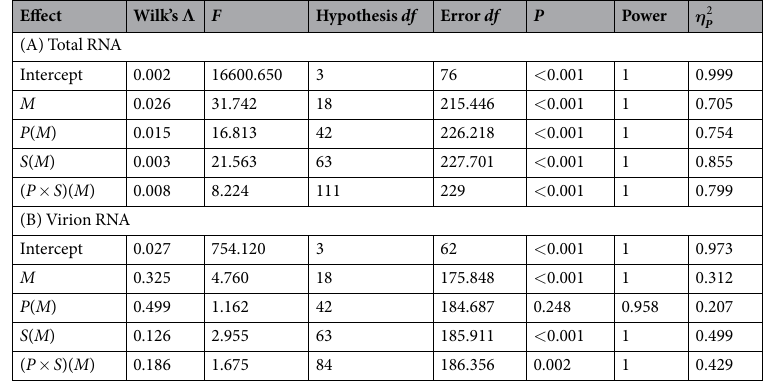
Table 1. Results of the MANOVA analysis for the RNA frequencies estimated from total and from virion RNA extractions in experiments with variable input ratios done in N. benthamiana . The model fitted is shown in equation (1). M : inoculated mixture of RNA segments; P ( M ): replicate plant inoculated with each mixture; S ( M ): type of sample from a plant inoculated with a given mixture; and ( P × S )( M ): interaction term between sample type and replicate plant inoculated with a given mixture M